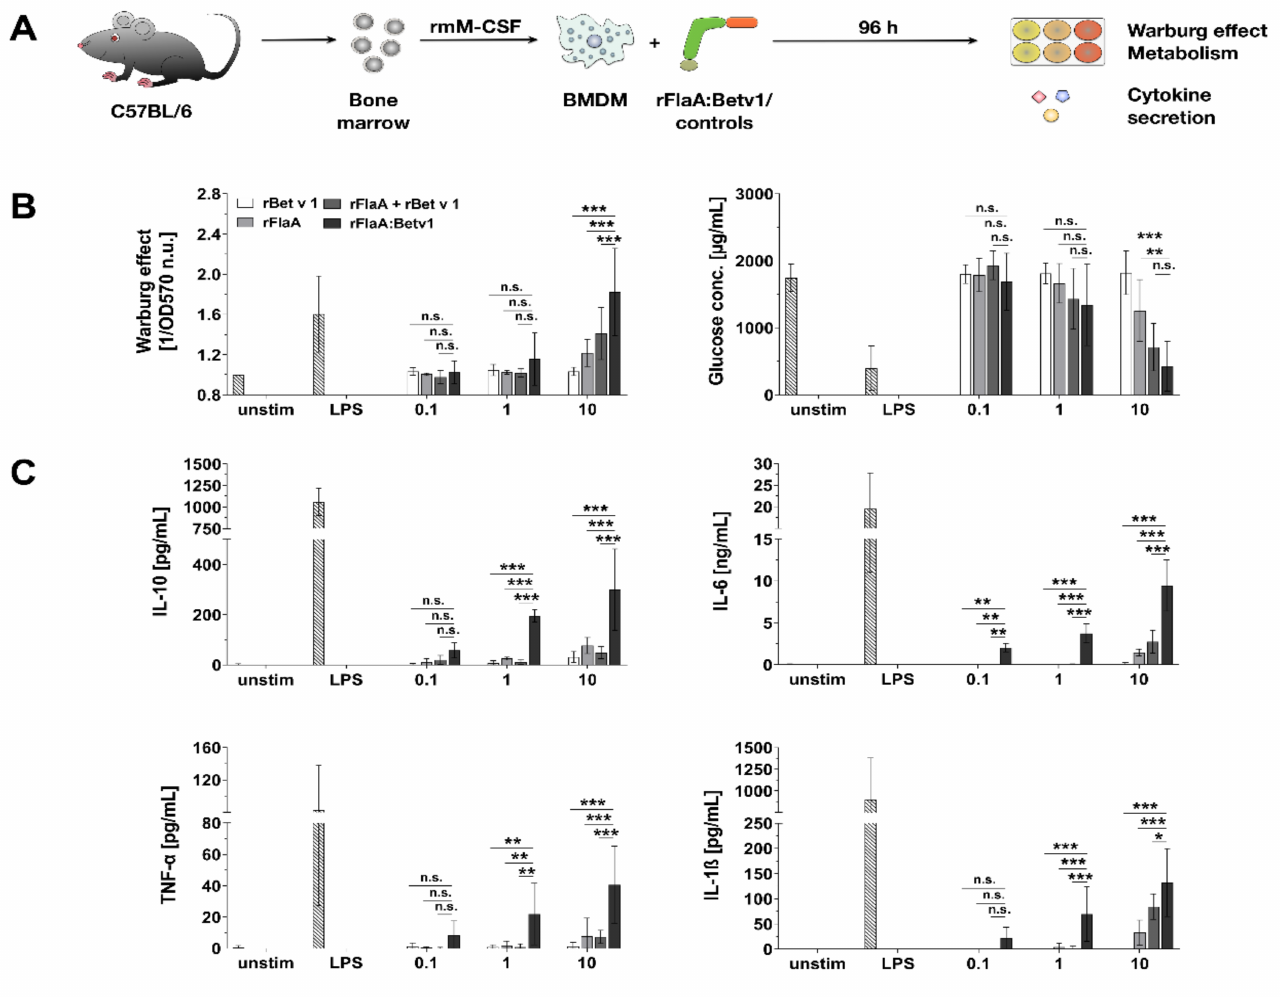
Figure 1. Activation of BMDM metabolism by rFlaA:Betv1 is accompanied by both pro- and anti-inflammatory cytokine secretion. C57BL/6 BMDMs were differentiated from mouse bone marrow and stimulated with the indicated equimolar protein amounts or LPS as a positive control for 96 h ( A ). Supernatants were analyzed for the induced Warburg effect and glucose consumption ( B ) as well as cytokine secretion by ELISA ( C ). Data are mean results of three independent experiments ± SD with two technical replicates per experiment. Statistical significance indicated as: n.s. p -value > 0.05, * p -value < 0.05, ** p -value < 0.01, *** p -value <